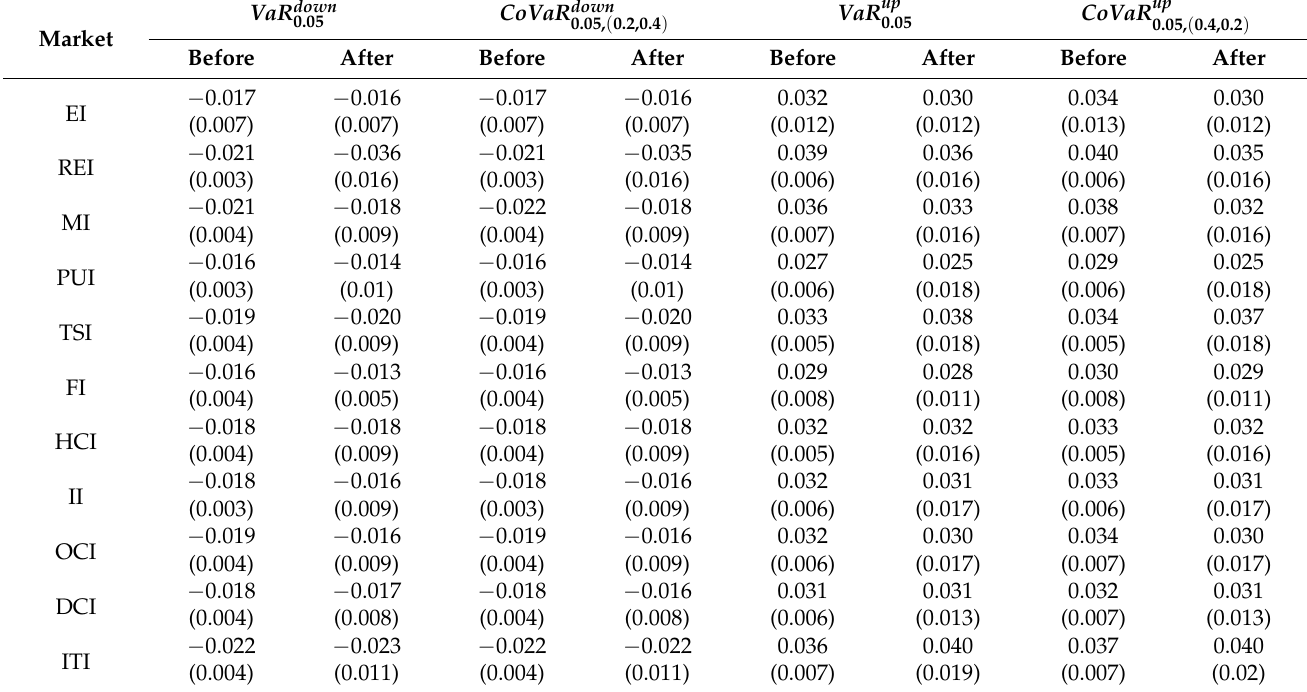
Table 8. Descriptive statistics of tail risk of moderate oil market on Chinese sector stock markets.